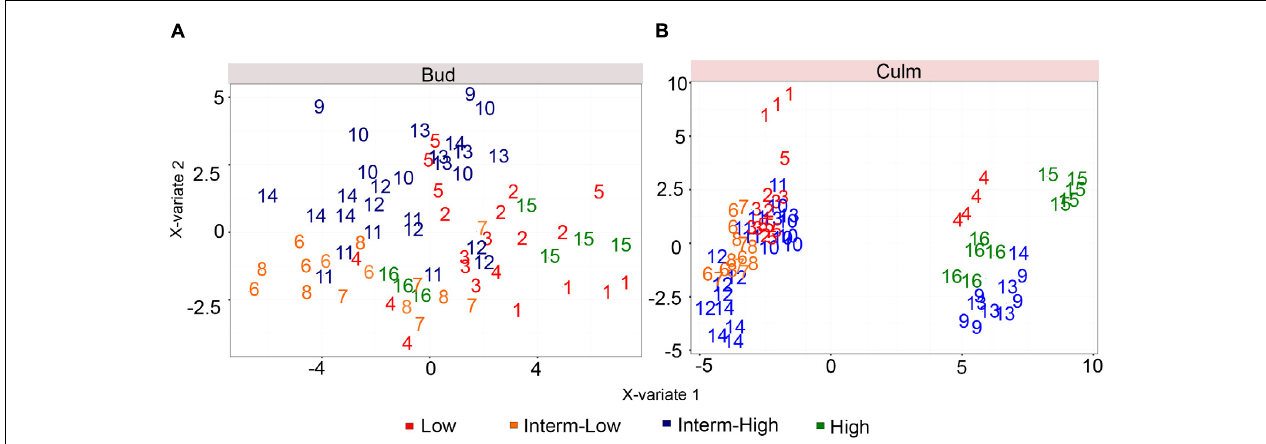
Table S1 . The color of the numbers denotes its sprouting group.